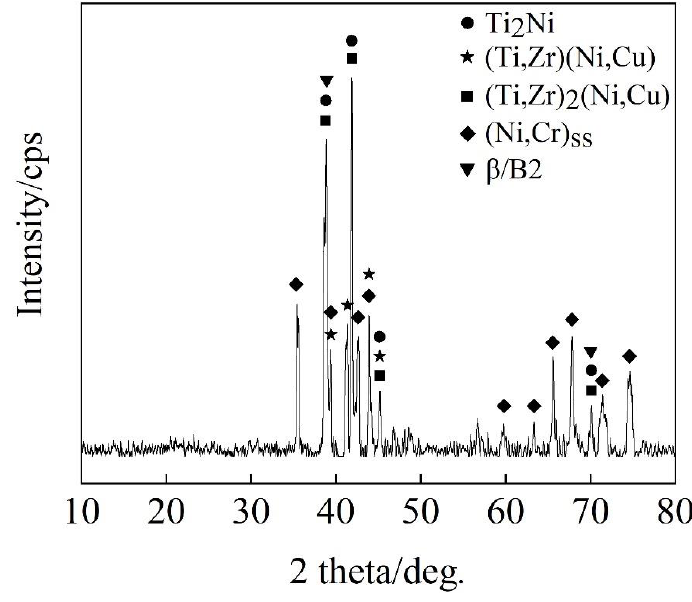
Figure 5. XRD pattern of the fracture surfaces (Ti 2 AlNb side) after shear test.